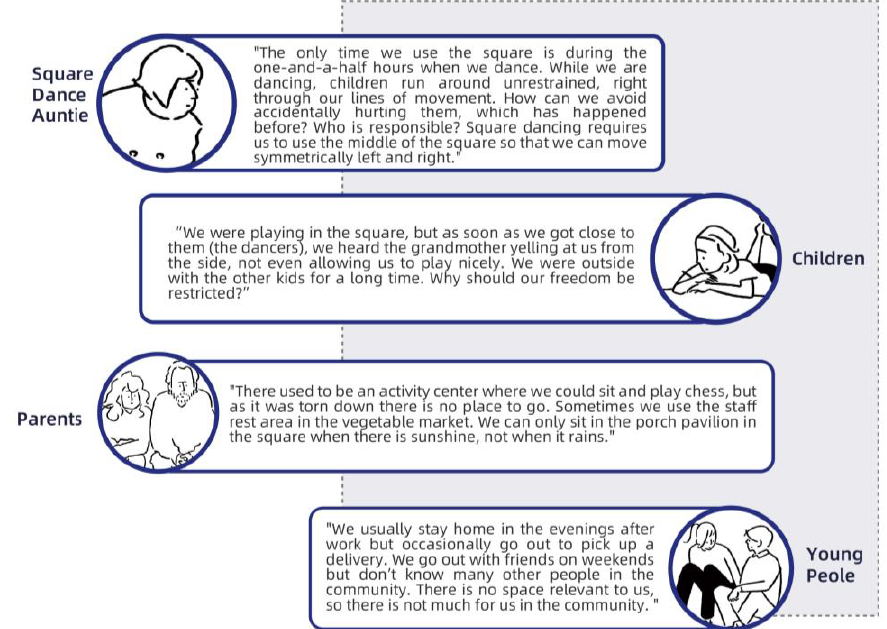
Figure 3. Community residents’ views.